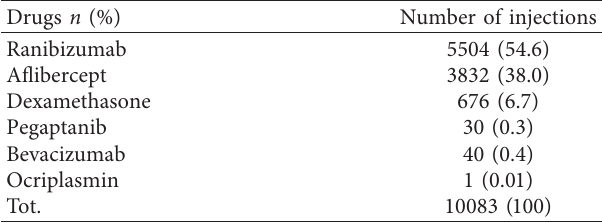
Table 2: Distribution of IVIs based on drugs